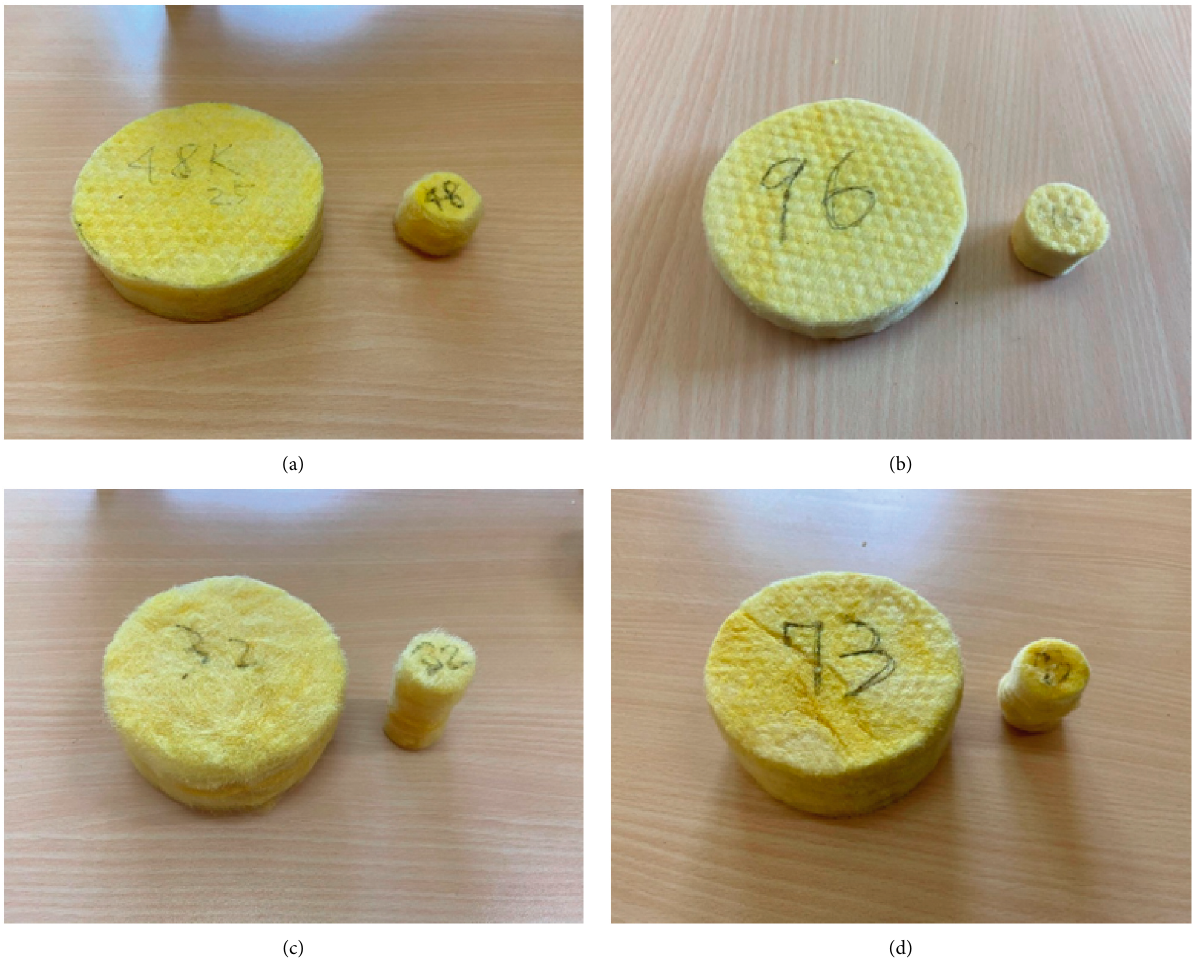
Figure 6: (a) 48K25, (b) 96K25, (c) 32K50, and (d) 73K50 impedance tube large tube and small tube